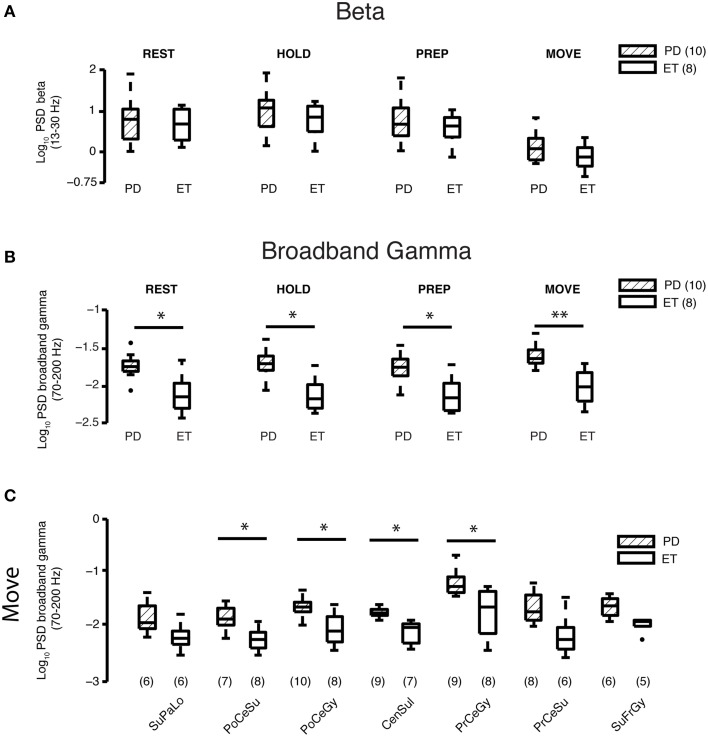
Beta and gamma spectral power at REST and during different task periods. (A) Comparison of average log10 beta power between Parkinson's disease (n = 10 subjects) and essential tremor (n = 8 subjects) groups for the REST and task periods. Horizontal line within the boxplot indicates median value, lower and upper box limits indicate the interquartile range (25 and 75%, respectively) and whiskers extend to minimum and maximum values of the dataset. Filled dark circles indicate outliers. No differences were found for any period. ET, essential tremor; PD, Parkinson's disease. (B) Comparison of average log10 broadband gamma power between Parkinson's disease (n = 10 subjects) and essential tremor (n = 8 subjects) groups for the REST and task periods. Boxplots constructed as in (A). *prs < 0.05, **prs < 0.01, refer to Results section for specific p-values. ET, essential tremor; PD, Parkinson's disease. (C) Cortical topography of the broadband gamma frequency band differences between Parkinson's disease and essential tremor groups, illustrated here for the MOVE period. Boxplots constructed as in (A). Values in parentheses indicate number of patients with contact coverage of a particular cortical region. CenSul, central sulcus; ET, essential tremor; PD, Parkinson's disease; PoCeGy, postcentral gyrus; PoCeSu, postcentral sulcus; PrCeGy, precentral gyrus; PrCeSu, precentral sulcus; SuFrGy, superior frontal gyrus; SuPaLo, Superior parietal lobule; *prs < 0.05, refer to Results section for specific p-values.